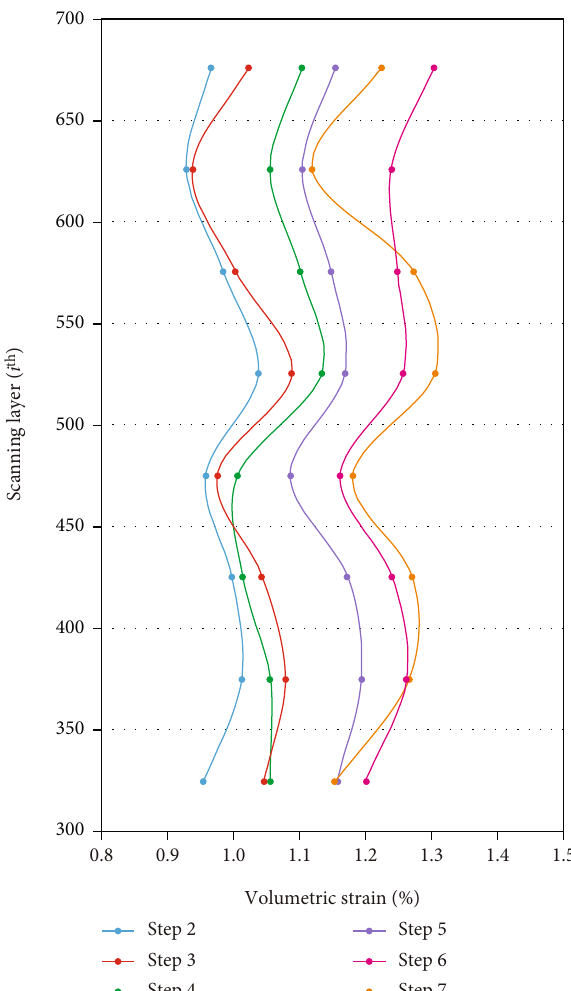
Figure 8: Volumetric strain distributions along with specimen height at di ff erent scanning steps for